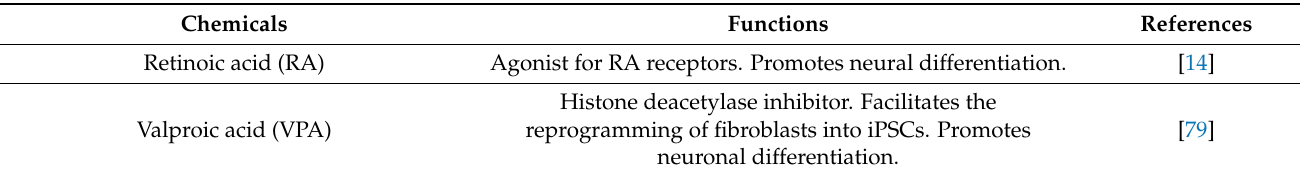
Table 1. Roles of small molecules in neuron